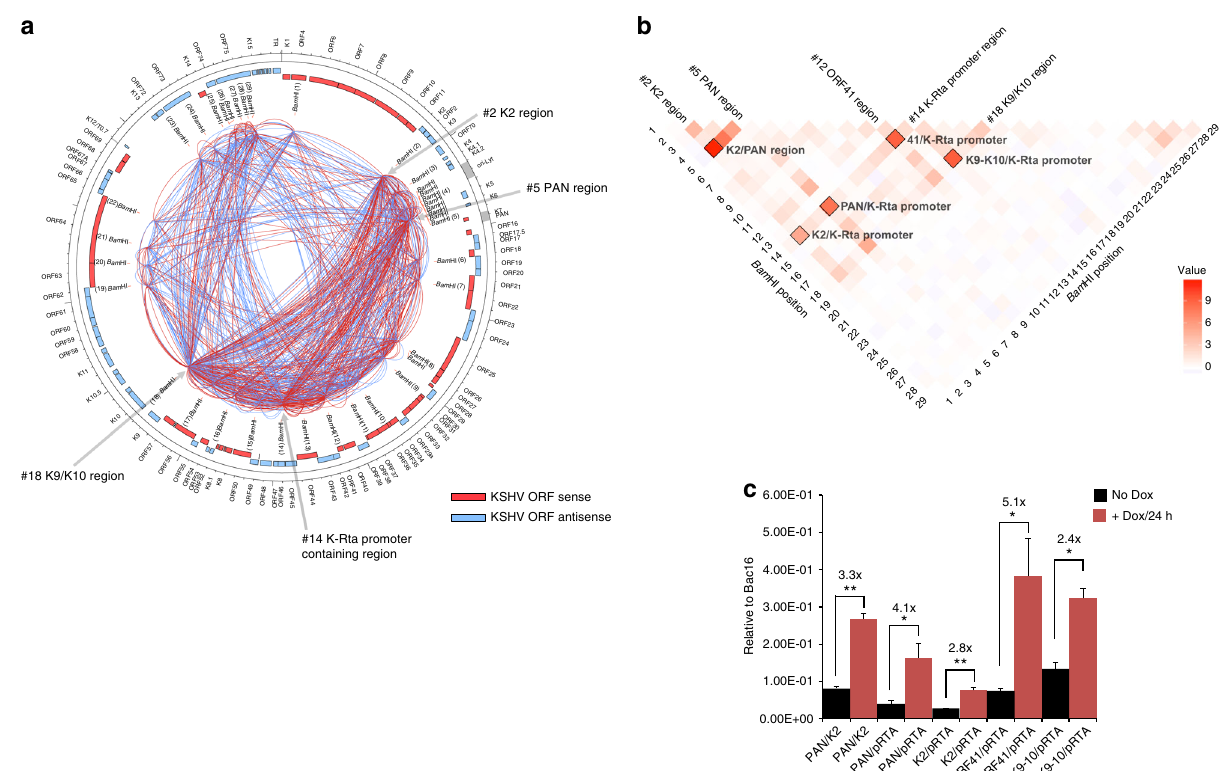
Fig. 2 Comprehensive mapping of KSHV genomic loop formation in TREx-K-Rta BCBL-1 cells with Capture Hi – C. a Circos diagrams depicting KSHV genomic links detected by Capture Hi – C. Each arc connects two Bam HI fragments and represents a distinct interaction. Blue- and Red-colored lines indicate genomic links occurring before or after of K-Rta induction, respectively. Black outer hatches mark genomic positions. ORF names are indicated in the outer circle. Positions of non-coding RNA are shown by gray shading in the outer circle and position of Bam HI sites are also indicated. b Regulation of genomic loops by KSHV reactivation in TREx-K-Rta BCBL-1. The relative increase/decrease of genomic links by induction of K-Rta was obtained by subtracting the relative sequence reads of non-reactivated TREx-K-Rta BCBL-1 cells from those in reactivated TREx-K-Rta BCBL-1 cells, and visualized in a heatmap by using R package ggplot2. Values are sequence reads at each position divided by the total sequence reads contained within the KSHV genome and multiplied by 10 3 . The numbers indicate positions of the Bam HI sites, which correspond to the Bam HI site numbering shown with in the Circos plot in panel a. Several Bam HI sites and their corresponding column in the heatmap are labeled, and genomic loops that increased during reactivation are marked by black squares. P -values for selected loops are listed in Table 2 part A (constitutive) and part B (induced). c Enriched Capture-C DNA ( Bam HI ligation products) was analyzed by qPCR for the contacts listed using DNA from TREx-K-Rta BCBL-1 cells ± dox. Values (mean ± SD, n = 3) represent signals obtained relative to a BAC16 Bam HI random ligation matrix. Fold increase (+dox/ − dox) is listed. (* p < 0.05; ** p < 0.01, Student ’ s t of PAN RNA 3000-fold above the level present in reactivated (0 and 8 h) i SLK BAC16 WT, PAN Mu, and K12 Mu cells and PAN Mu cells transfected with empty vector (Fig. 5b, left panel). the degree of K-Rta recruitment to each RE was examined. In WT-infected cells, K-Rta binding was very robust at the K12 RE, but reduced binding at this RE was observed with either the K12 Mu or PAN Mu virus (Fig. 5a, right panel). A similar reduction in PAN RE binding was observed in cell lines containing either of the mutant viruses, although the overall binding of K-Rta was lower than that observed at the K12 RE (Fig. 5a, left panel). Taken together, these results suggest that the binding of K-Rta to its target promoters is dependent, at least in part, through clustering of the sites via genomic looping and the formation of ACHs.